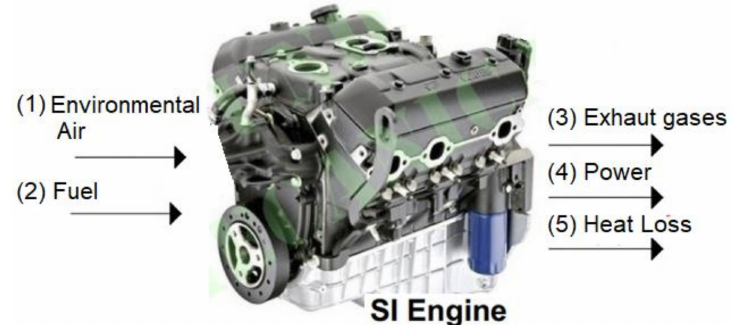
Figure 1. Energy balance in the SI